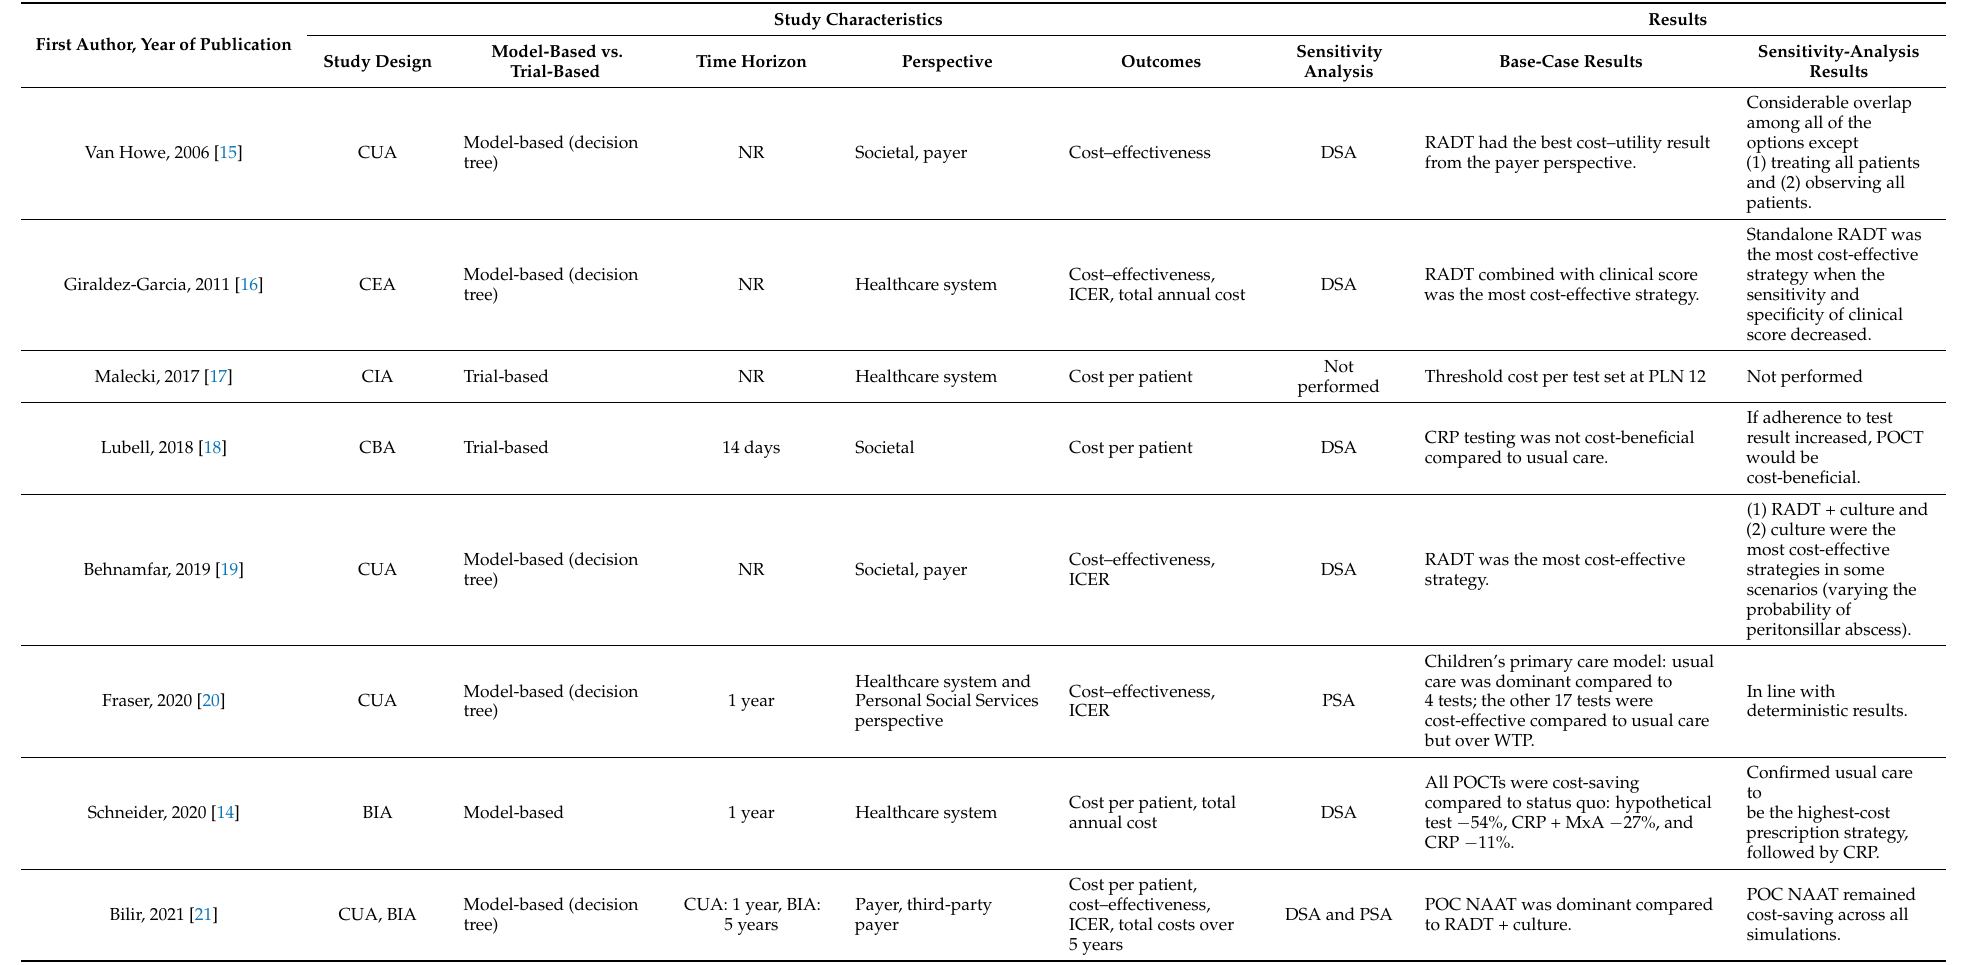
Table 2. Methodological characteristics and results of economic evaluations of antimicrobial stewardship strategies including point-of-care testing in pediatric patients with respiratory-tract